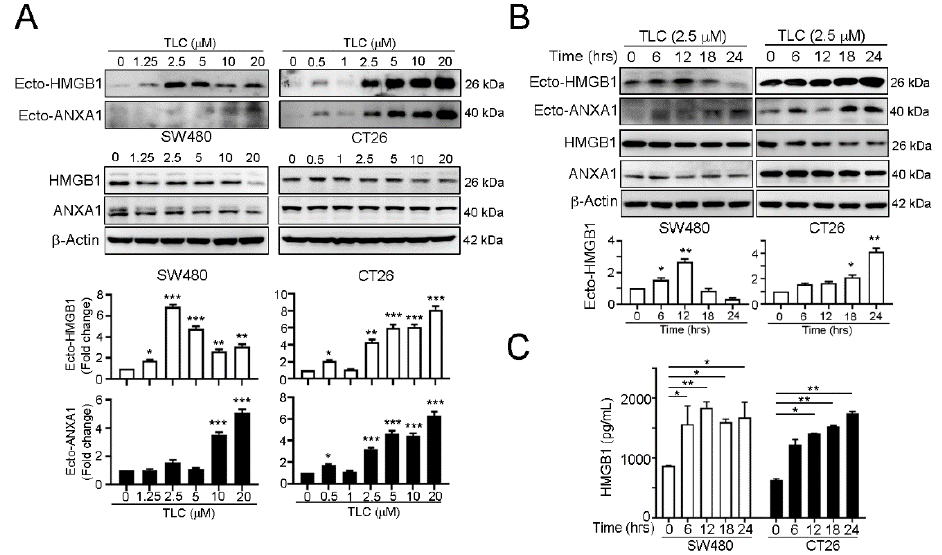
Figure 2. Lipotecan triggered HMGB1 and ANXA1 release. ( A ) SW480 and CT26 cells were treated with diverse concentrations for 24 h and examined by immunoblotting. The conditioned medium was concentrated and analyzed by immunoblotting. Quantification of these results is shown ( n = 3). * p < 0.05, ** p < 0.01 and *** p < 0.001. ( B ) SW480 and CT26 cells were treated with 2.5 µ M TLC for 6, 12, 18 and 24 h. The treated cells were harvested for immunoblotting. The quantification analysis is shown below ( n = 3, * p < 0.05 and ** p < 0.01). ( C ) The conditioned medium from SW480 and CT26 cells that treated with 2.5 µ M TLC for 6, 12, 18, and 24 h was harvested for HMGB1 ELISA ( n = 3, means ± S.D.s., * p < 0.05 and ** p < 0.01). More details of western blot, please view at Figures S3 and S4.